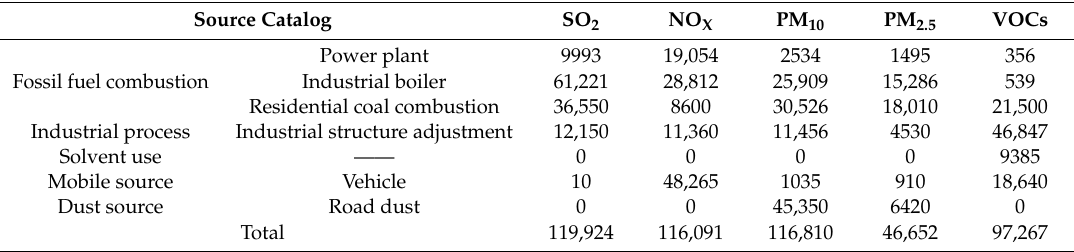
Table 1. Emission reduction of air pollutants by implementing clean air action